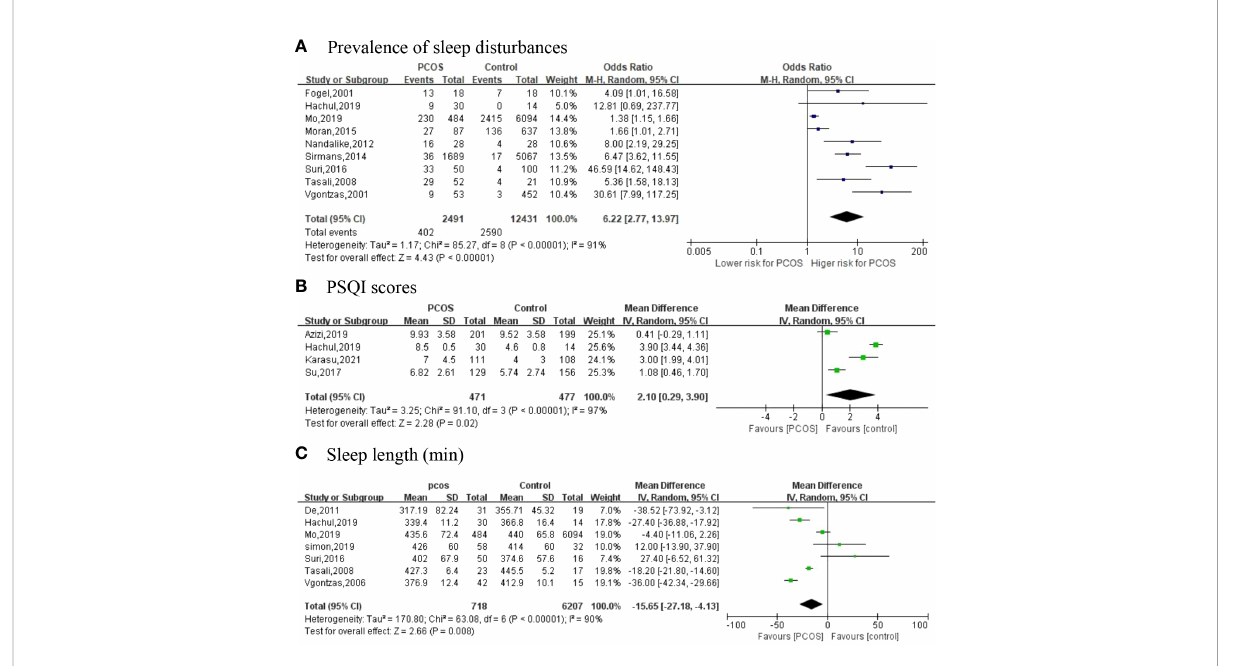
FIGURE 2 The primary outcomes [ (A) Prevalence of sleep disturbances; (B) PSQI scores; (C) Sleep length